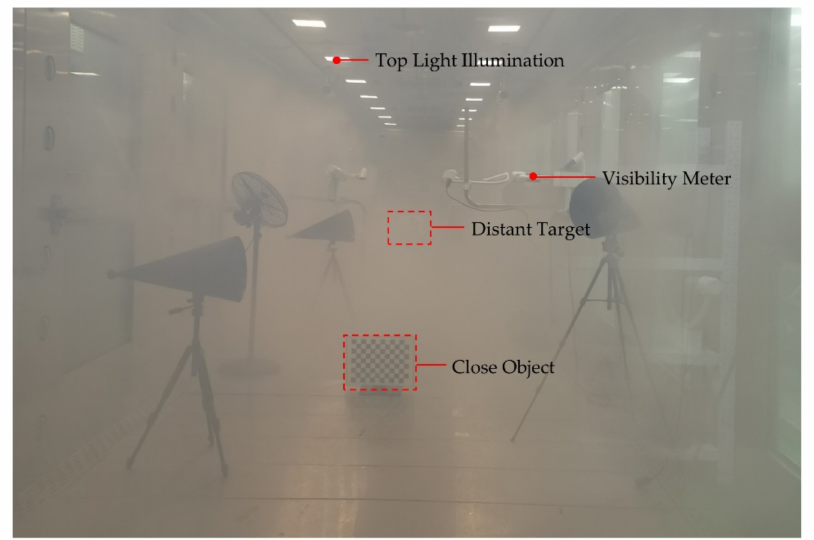
Figure 4. Experimental environment with thin fog. After twelve-minute fog filling, the visibility in the process of natural subsidence can remain stable for a period of